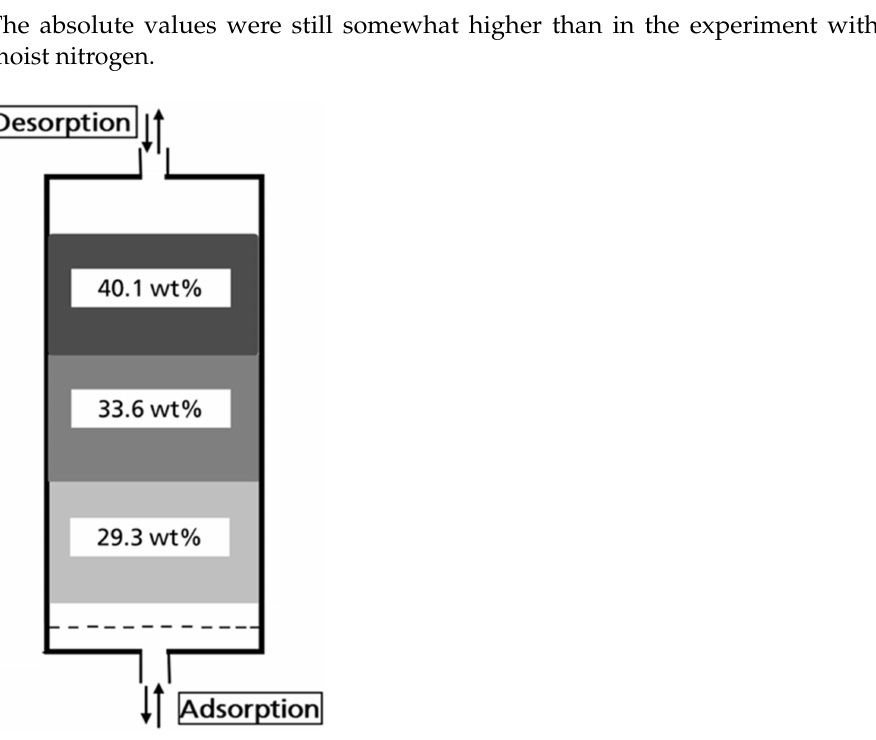
Figure 11. Water content of the activated carbon bed after desorption in the 260th cycle.